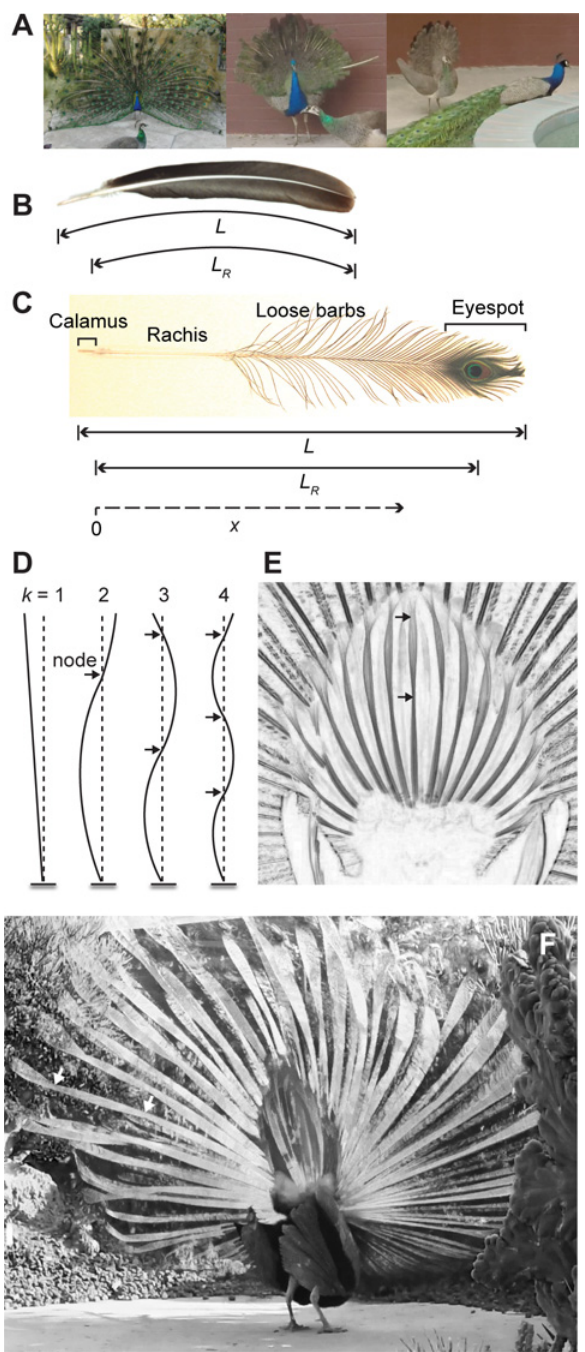
Fig 1. Peafowl displays and feather anatomy. (A) Photos (left to right) show an adult male, a subadult male, and a female performing train-rattling (males) or covert-rattling (female) displays. Feather anatomy and measurements taken from (B) a typical adult peacock rectrix (tail feather) and (C) an eyespot train feather. The length of the rachis outside the body (i.e., excluding the calamus), L R , is used to characterize the mechanics of vibrations. The position along the rachis, x , is measured from the insertion point into the skin (top of the calamus) as shown. (D) Examples of normal modes of oscillation for a cantilever with a fixed tip, indexed by the integer k , where k = 1 corresponds to the lowest resonant frequency. For a given pattern of vibration corresponding to a normal mode, the value of k can be determined by counting the number of nodes (i.e., points of zero motion, indicated with arrows). (E) Motion of tail feathers viewed from behind a